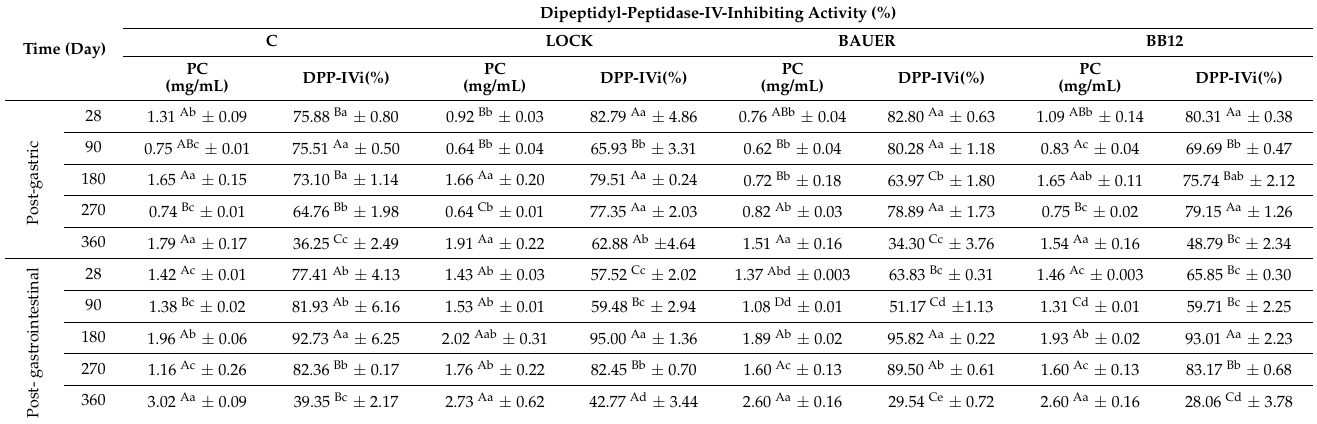
Table 4. Dipeptidyl peptidase IV inhibiting activity (DPP-IVi; %) and peptides concentration